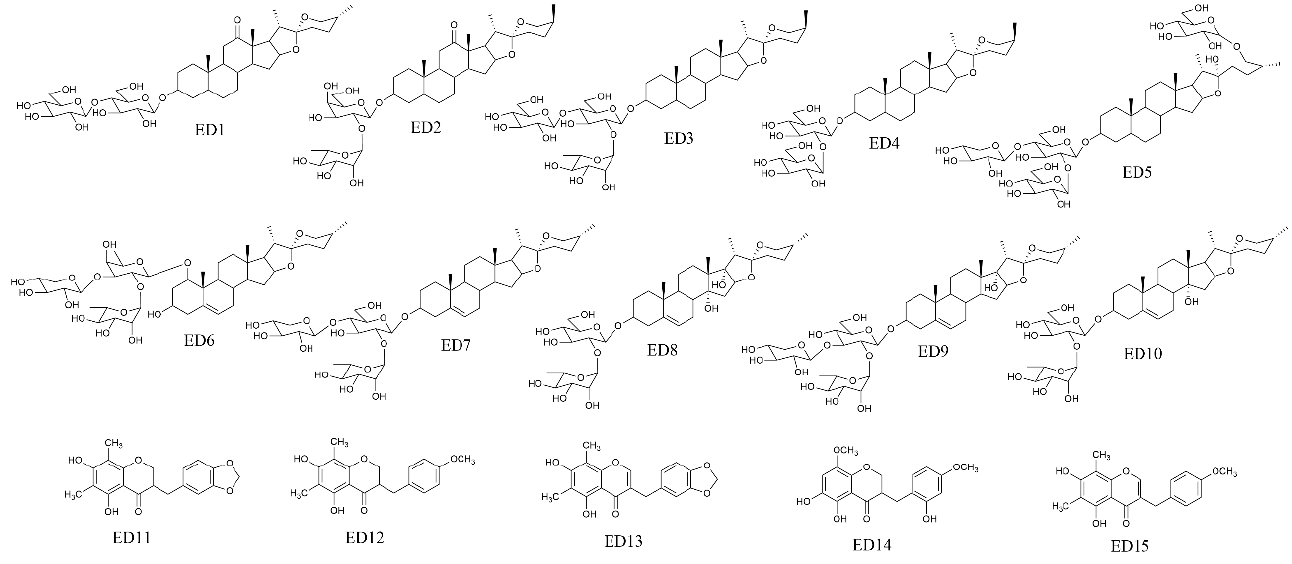
Figure 4. The chemical structures of the compounds that bound to 16HBE, HPAEpiCs and HUVECs. ED1: (25 R ) ‐ 3 β ‐ [( O ‐ β ‐ D ‐ glucopyranosyl (1 → 4) ‐ β ‐ D ‐ galactopyranosyl) oxy] ‐ 5 β ‐ spirostan ‐ 12 ‐ one, ED2: (25 S ) ‐ 3 β ‐ [( O ‐α‐ L ‐ rhamnopyranosyl (1 → 2) ‐ β ‐ D ‐ galactopyranosyl)oxy] ‐ 5 β‐ spirostan ‐ 12 ‐ one, ED3: